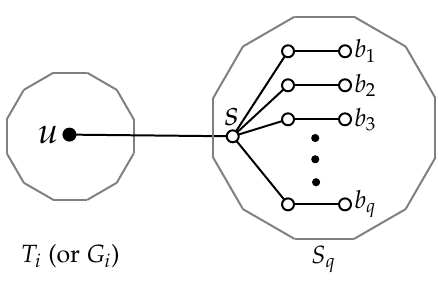
Figure 3. The operations: T 1 or T 2